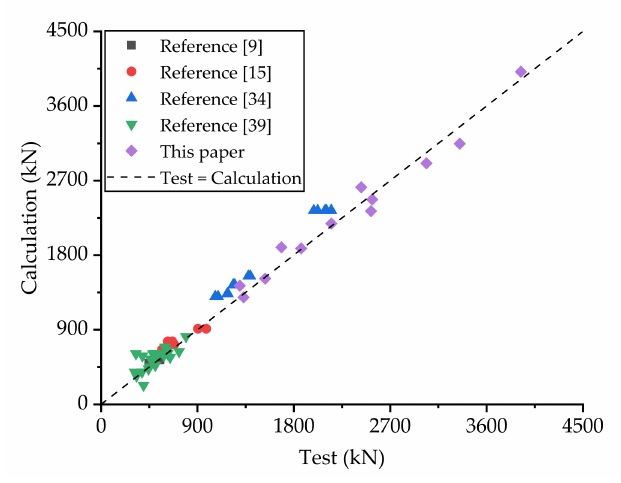
Figure 10. Comparison between test and calculation results of different